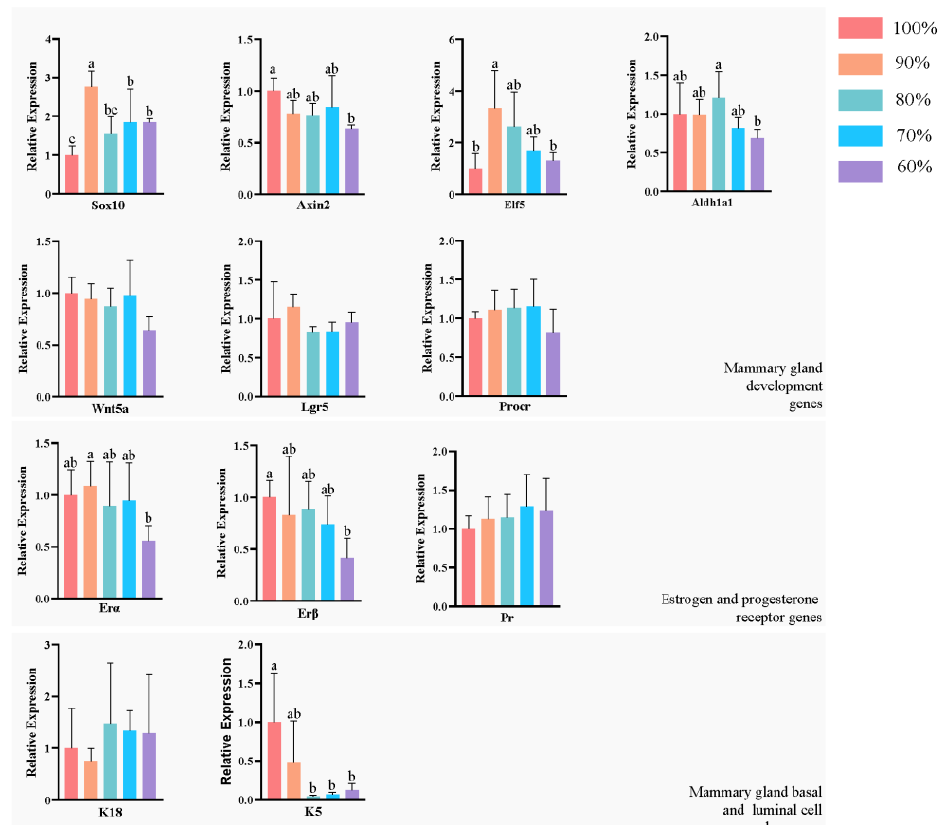
Figure 5. Mammary gland proliferation- and hormone-related gene expression in offspring. Identical letters or no letters are not significant difference ( p > 0.05), while different letters indicate significant difference ( p < 0.05) determined by one-way ANOVA followed by a Sidak multiple-comparison test. Bar charts represent mean, error bars represent SD. Sox10: SRY (sex-determining region Y)-box 10. Axin2: Axis inhibition protein 2. Elf5: E74-like factor 5. Aldh1a1: aldehyde dehydrogenase family 1. Wnt5a: wingless-type MMTV integration site family, member 5A. Lgr5: leucine-rich repeat-containing G-protein-coupled receptor 5. Procr: protein C receptor. ER α : estrogen receptor 1 (alpha). ER β : estrogen receptor 2 (beta). Pr: progesterone receptor. K18: keratin 18. K5: keratin 5.